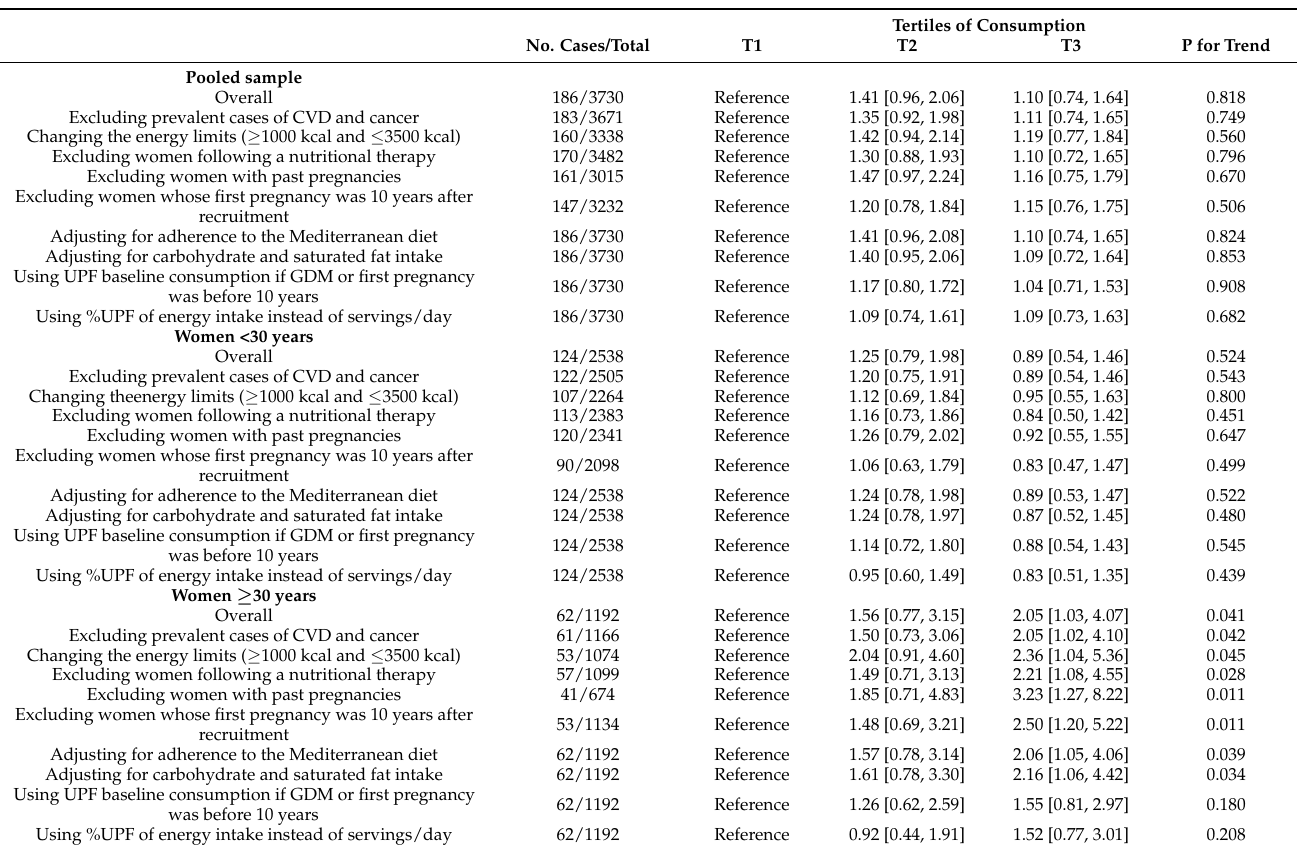
Table 4. Sensitivity